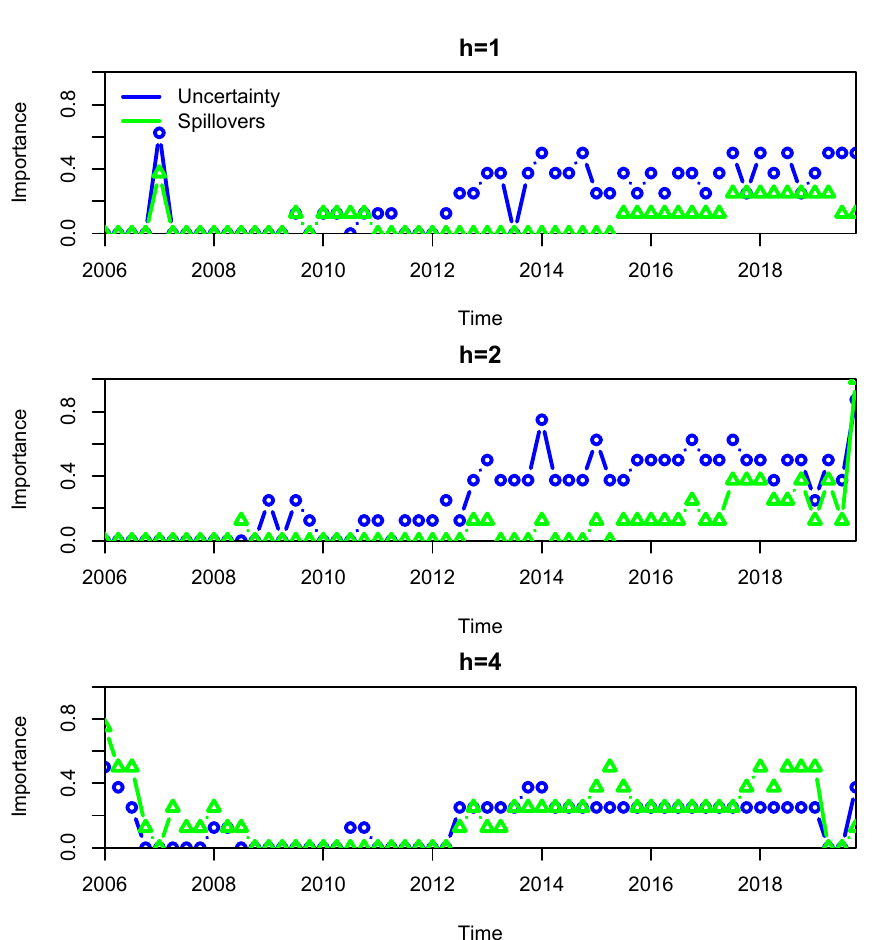
Figure 7. Importance of uncertainty and international spillovers. The results are for WTI and a recursive-estimation window. Importance is defined as the number of nonzero coefficients estimated for uncertainty divided n u and similarly for spillovers. Hence, zero means that all coefficients of, for example, uncertainty are zero in a given forecasting period, and one means that all coefficients of uncertainty/spillovers are nonzero. The time axis refers to the period in which a forecast is being